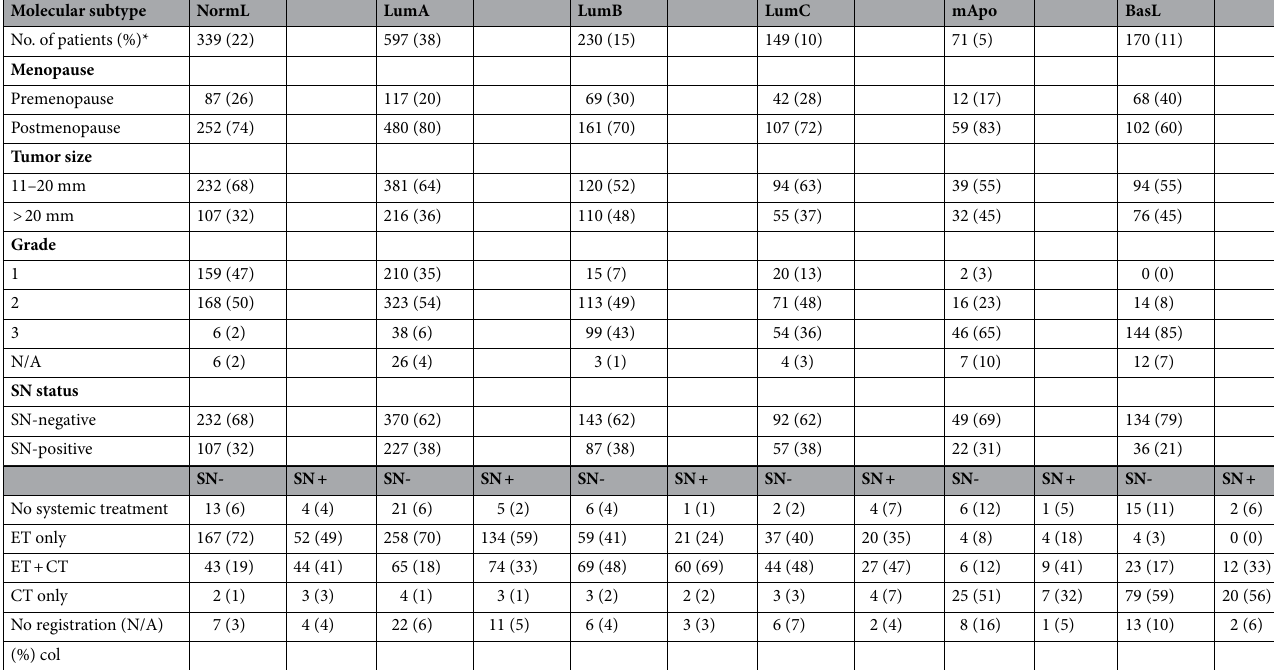
Table 1. Distribution of molecular subtypes, menopausal status, tumor size, malignancy grade, and sentinel node (SN) status for 1556 patients. ET endocrine therapy, CT